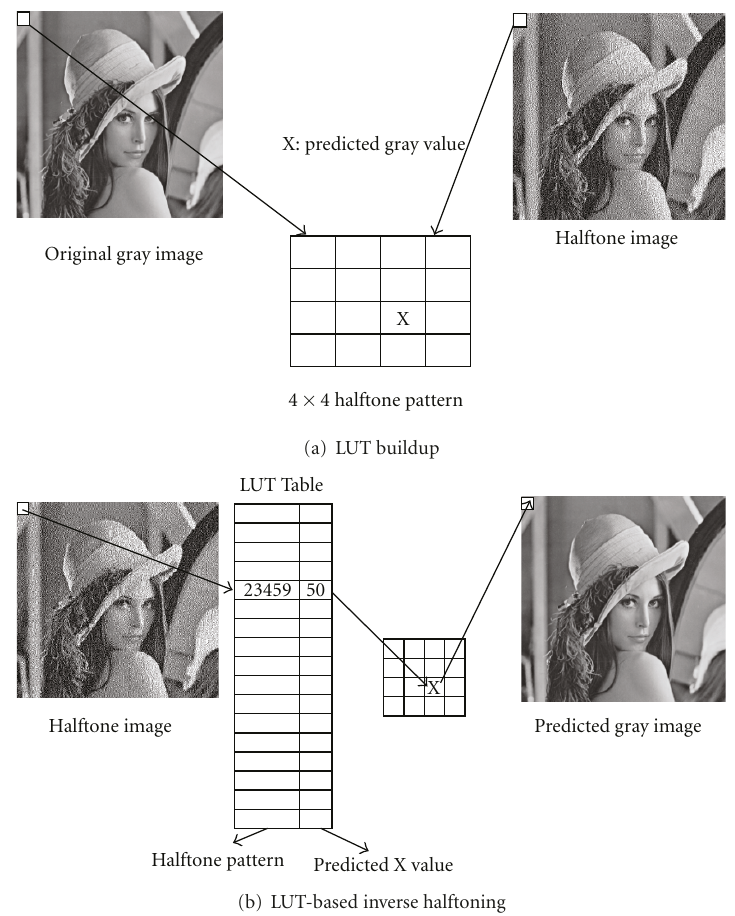
Figure 2: LUT-based method includes two procedures (a) LUT Buildup (b) LUT-based inverse halftoning